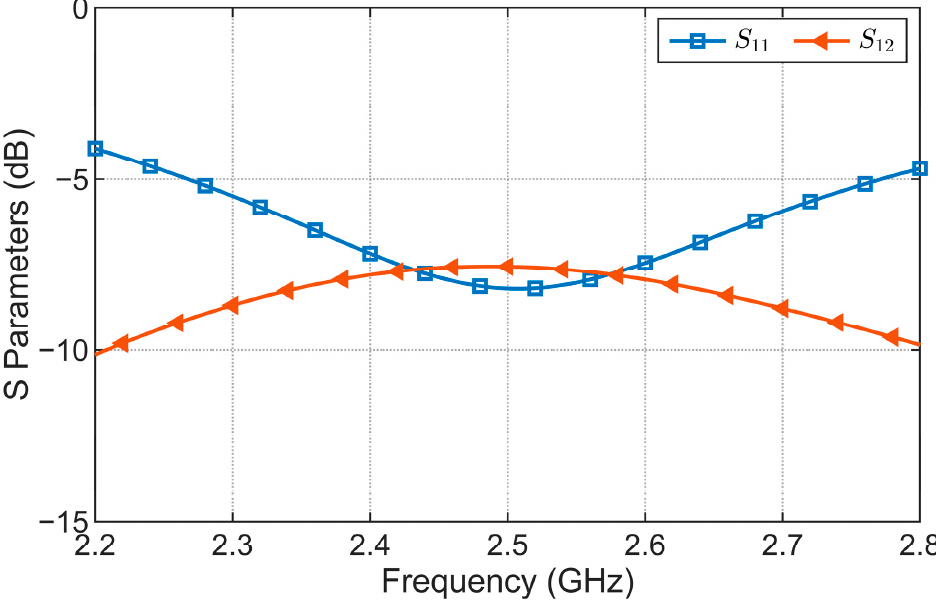
Figure 5. ( a ) Top view and ( b ) front view of the coupled three-element array. The height of the monopole above the ground is h a = 28.6 mm. The designed operating frequency is f 0 = 2.5 GHz, and its corresponding quarter wavelength is 30 mm. The length of h a is smaller than it, because the strong couplings between the antennas are equivalent to the loads of the antennas resulting in the antenna-operating frequency shifting to lower frequencies. Figure 6 illustrates the simulated scattering parameters. Due to the symmetry of the three ports, only the self and mutual parameters between ports 1 and 2 are presented here. As can be seen, the antenna operates at 2.5 GHz, and the port isolation is only 7.5 dB.